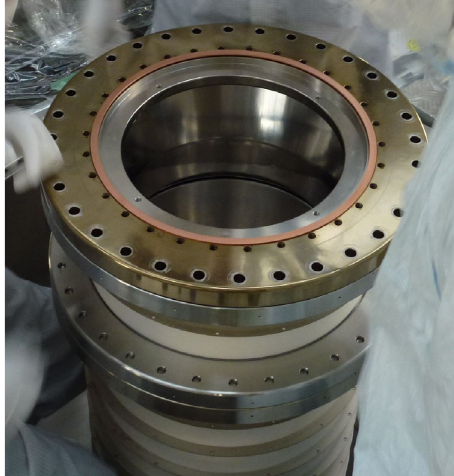
FIG. 5. Photograph of the two-segment insulator on the top of the existing ten-segment